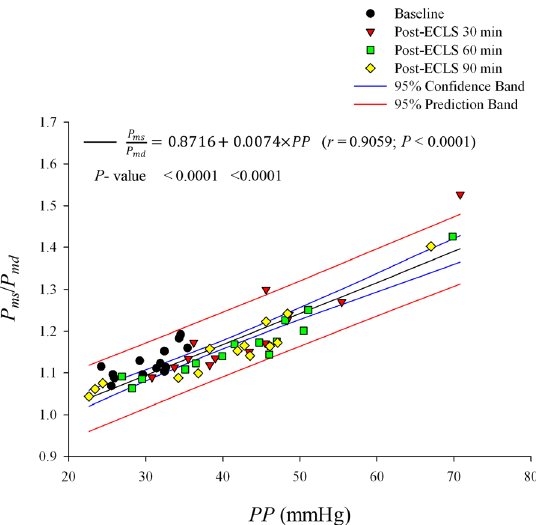
Figure 5. Potential role of PP in reflecting P ms / P md in rats before and after ECLS. P ms / P md was significantly positively related to PP by ECLS. P md = mean diastolic pressure; P ms = mean systolic pressure; PP = pulse